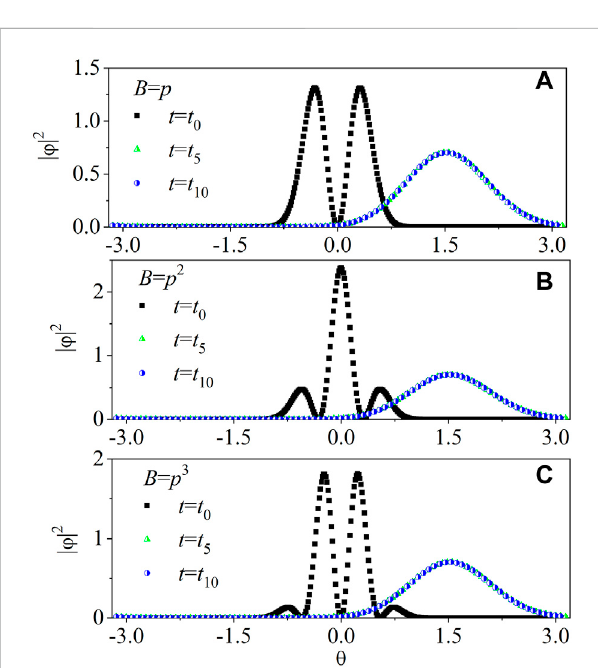
FIGURE 6 Probability density distributions in real space at the time t = t 0 (squares), t 5 (triangles), and t 10 (circles) with B = p (A) , p 2 (B) , and p 3 (C) . The parameters are the same as in Figure 2.